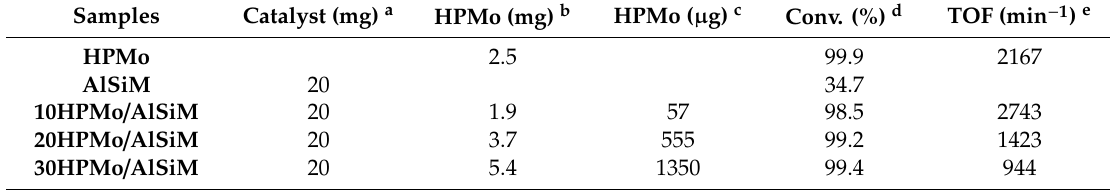
Table5. Conversiondata(%)andturnoverfrequency(TOF)forthecatalysts(10, 20and30)HPMo / AlSiM. Samples Catalyst (mg) a HPMo (mg)